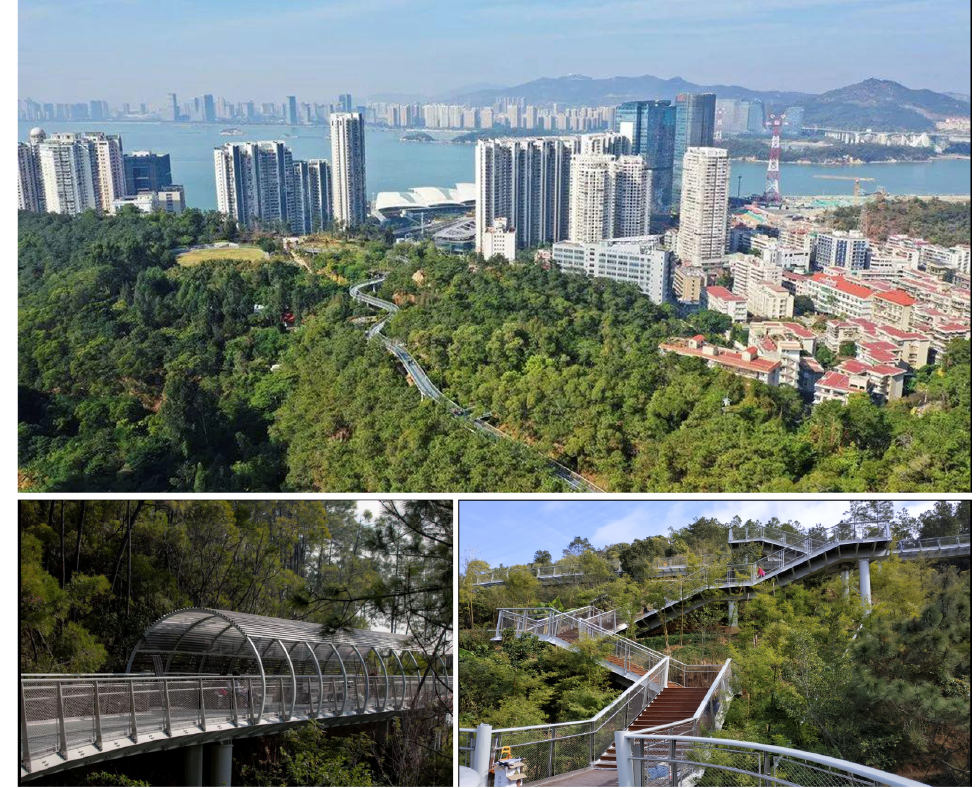
Figure 9. Photos of the Xiamen Mountains-to-Sea Trail.